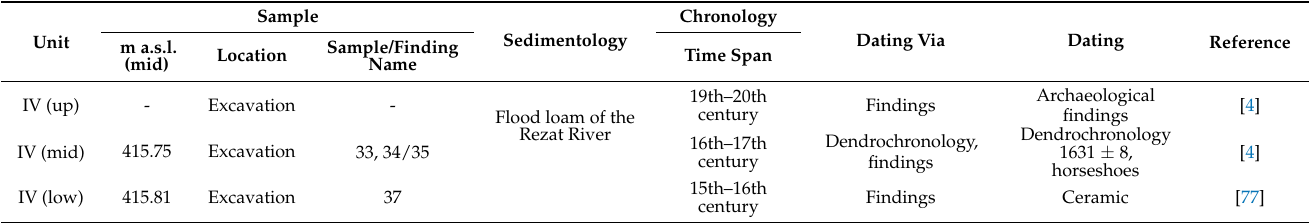
Table 4. Chronostratigraphy for the Rezat flood loam (Unit III) above the remains of the Fossa Carolina in the northern section by archaeological dating and dendrochronology (from 2013 excavation—Schnitt 1 [4,77]).